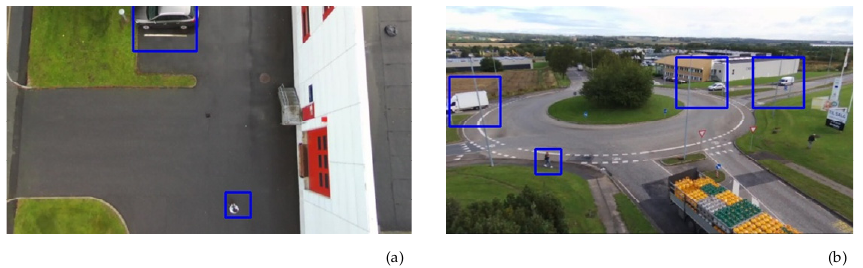
Figure 7. The classification result of OTNet-C. The larger boxes and the smaller boxes represent different categories. ( a ) Result for the parking lot scene. ( b ) Result for the circular road scene.